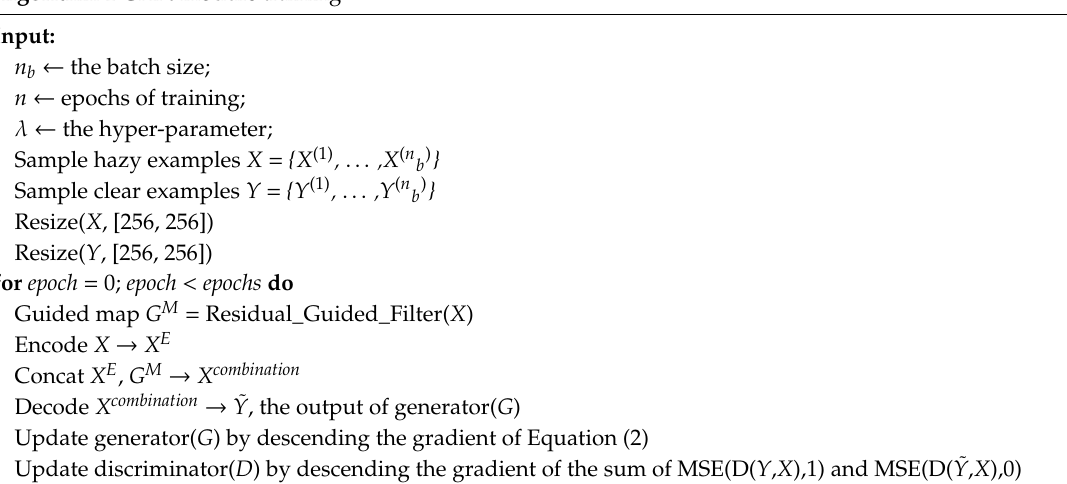
Algorithm 1 GAN module